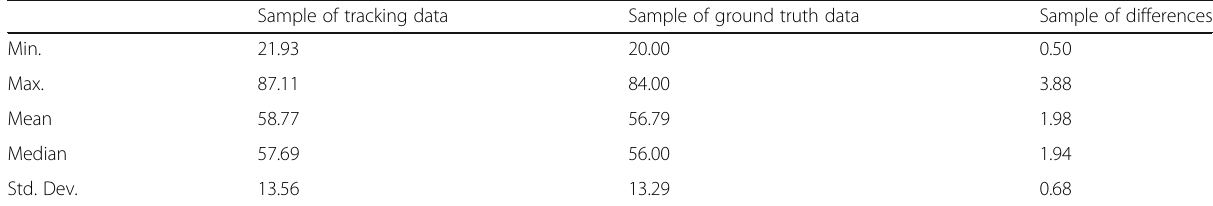
Table 2 Descriptive characteristics of tracking and ground truth data samples and difference sample